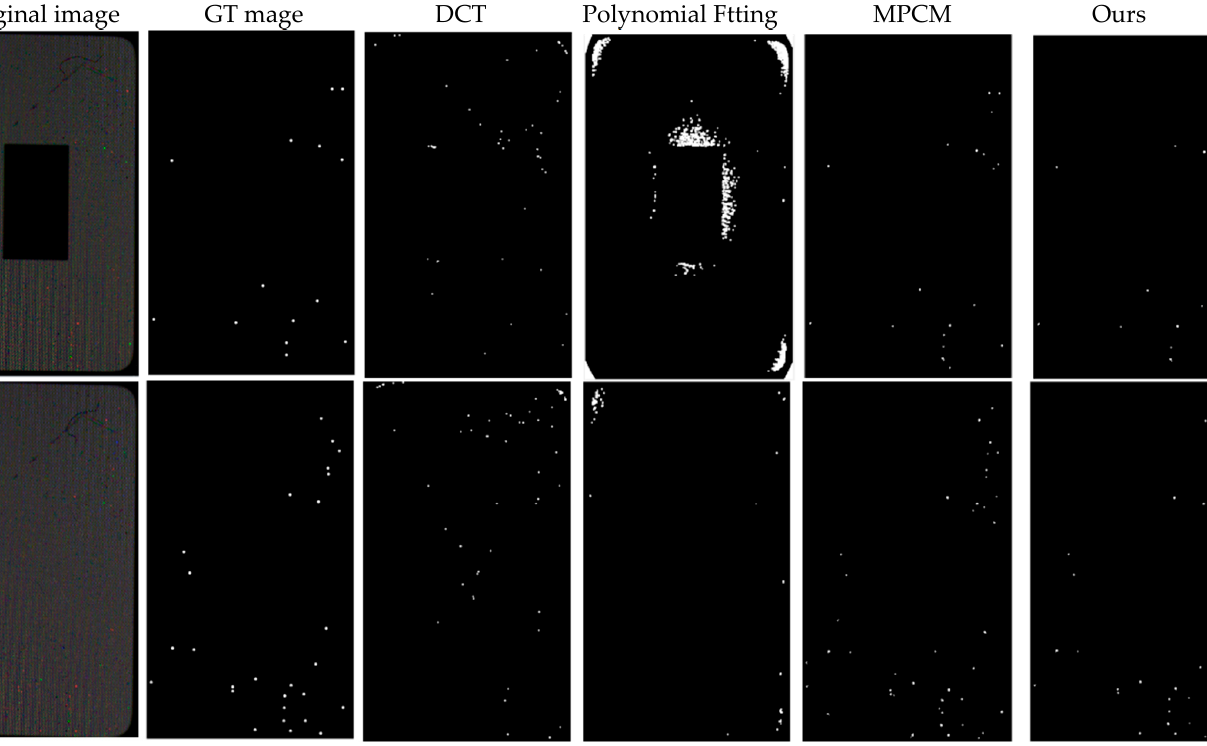
Figure 8. Comparison of test results of different methods.